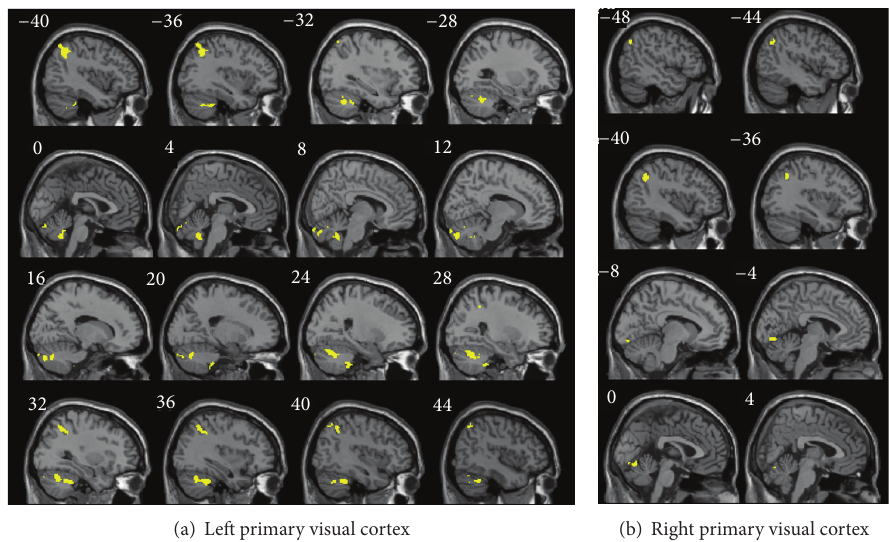
Figure 3: Overlapping brain areas with alterations in functional connectivity with the left primary visual cortex (a) and the right primary visual cortex (b) are shown for amblyopic individuals (cluster size larger than 70 voxels). The details of the regions can be found in Table 2.